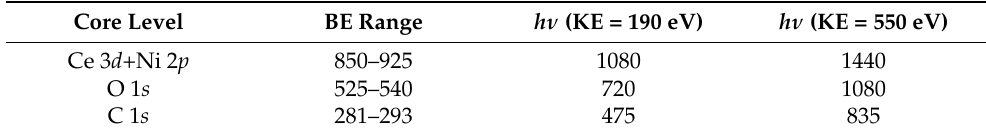
Table 1. Photon energies used for the acquisition of the core levels studied in this paper. All energies are in